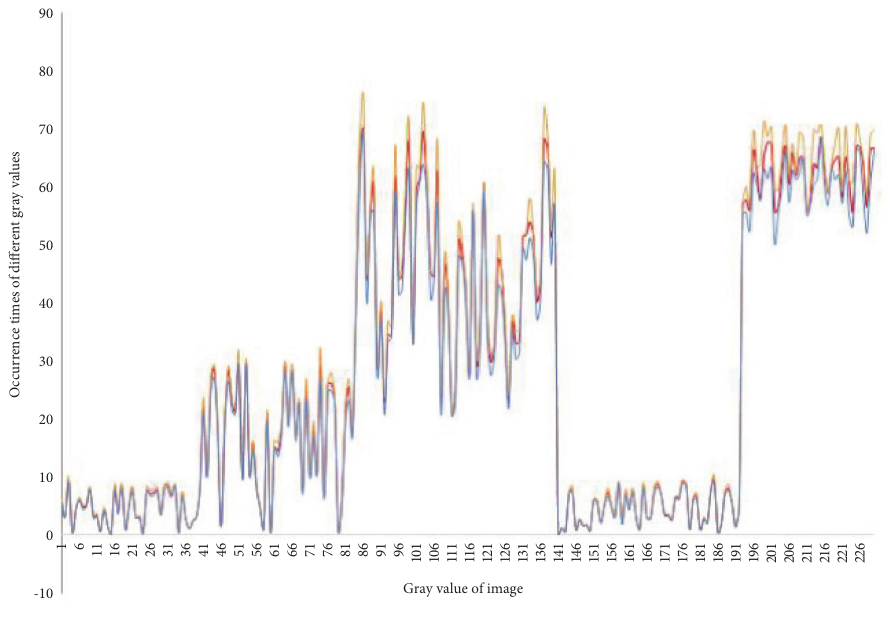
Figure 2: RGB color histogram.